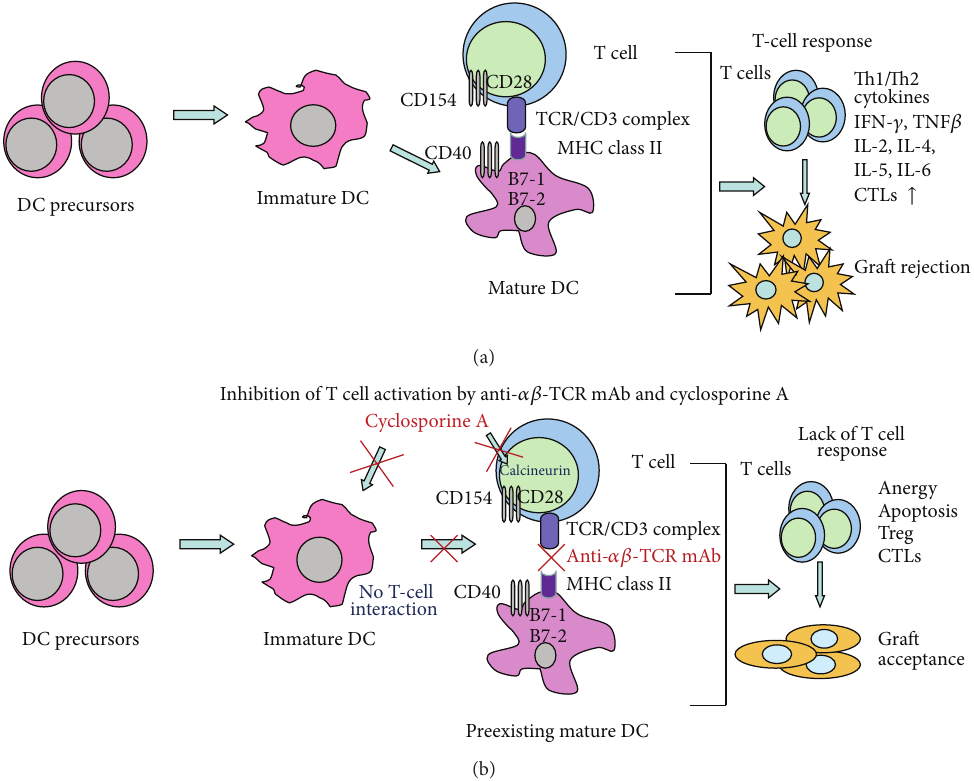
Figure 2: (a) Interaction of memory T cells and antigen pretention cells (APCs) without immunosuppression induced T-cell response and allograft rejection. (b) Selective targeting of 𝛼𝛽 -TCR of TCR/CD3 complex inhibits the first signal of T-cell activation. Inhibition of immune response is enhanced by CsA, which inhibits IL-2 production by T cells and reduces expression of costimulatory molecules of dendritic cells. Lack of immune response by T cells facilitates allograft